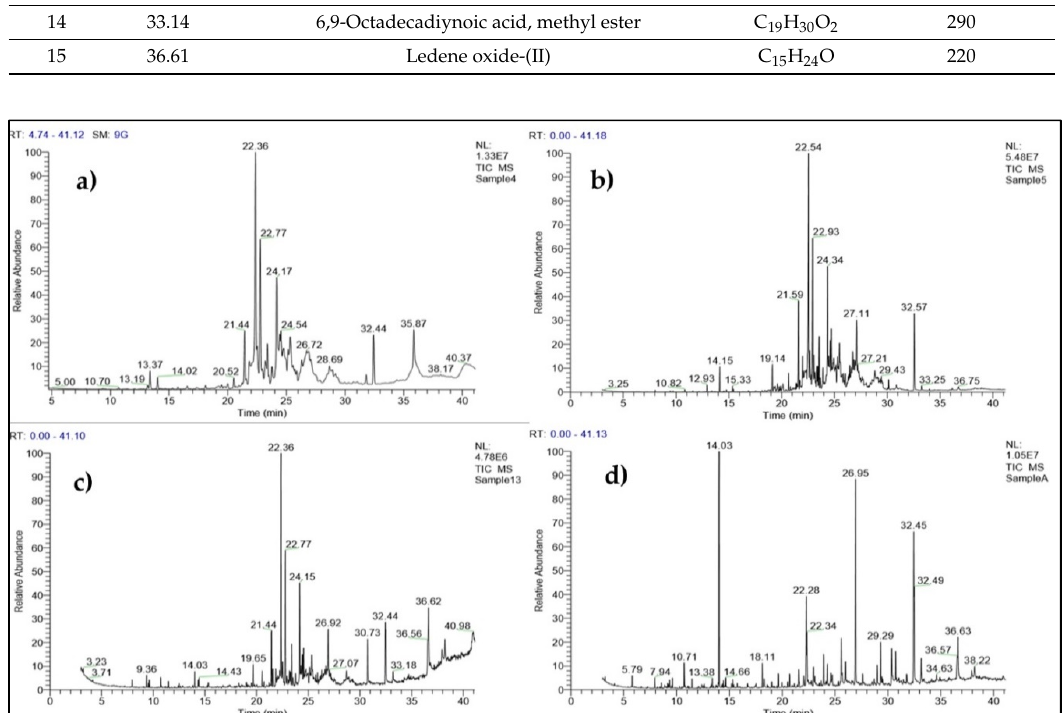
Figure 2. ( a – d ) Gas Chromatography Mass Spectroscopy (GC-MS) of compounds identified from secondary metabolite crude extracts of ( a ) T. harzianum (PGT4), ( b ) T. reesei (PGT5), ( c ) T. reesei (PGT13) and ( d ) co-culture of Trichoderma spp. (PGTA). Table 2. List of compounds of Trichoderma harzianum (PGT4) detected by Gas Chromatography Mass Spectroscopy (GC-MS). RT—Retention Time.